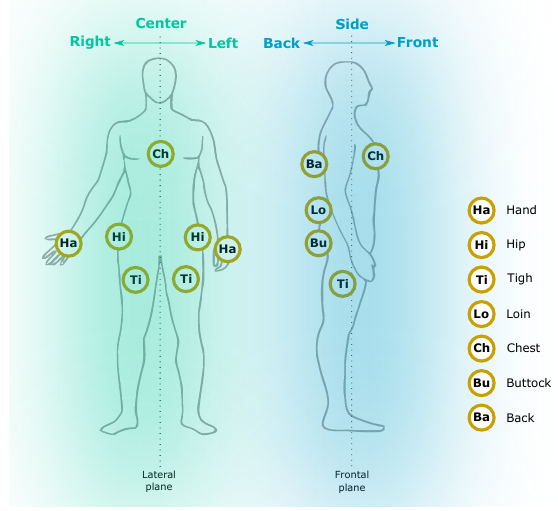
Figure 2. Layout of all smartphone positions considered in the FRIgait dataset.